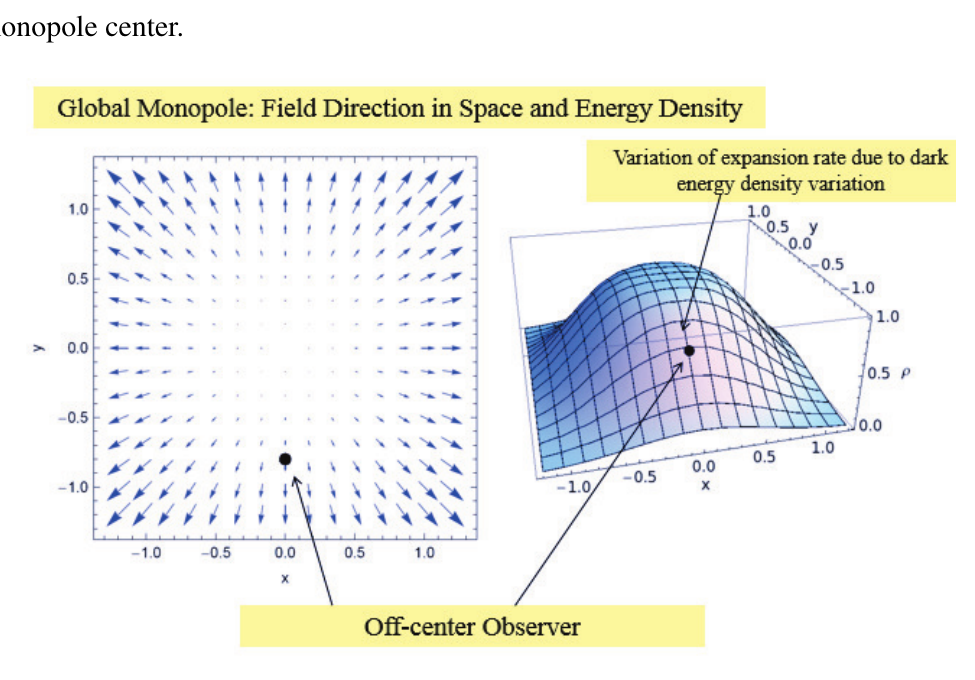
Figure 5. An off-center observer in the core of a global monopole will naturally experience an anisotropy in the expansion rate due to the higher vacuum energy density in the direction of the monopole